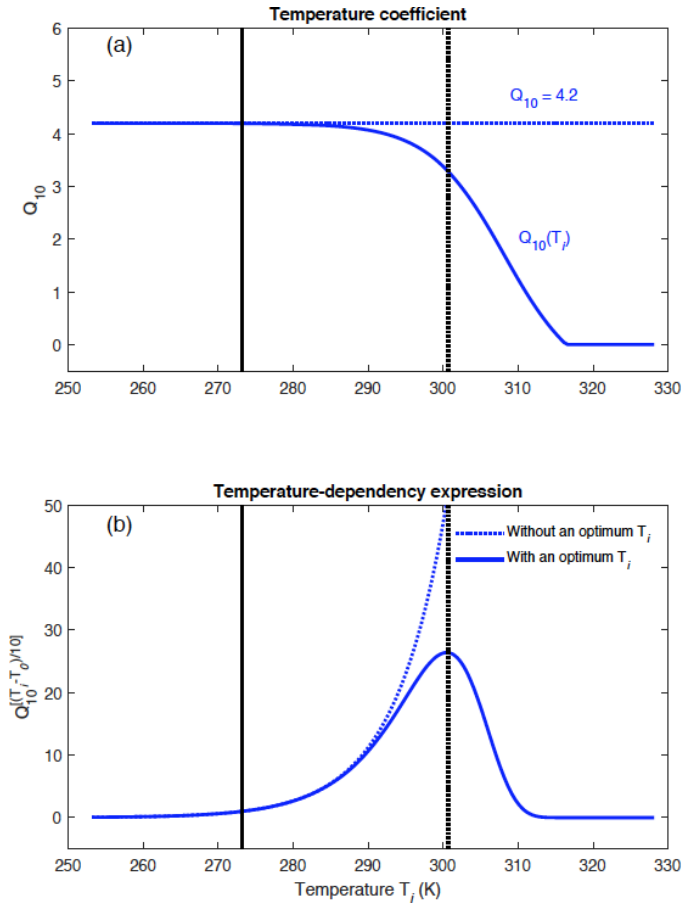
Figure A1. (a) Differences between a constant Q 10 coefficient and a temperature-dependent Q 10 (T i ) coefficient, and (b) implications for the temperature-dependency expression for CH 4 production ( Q 10 [ (T i − T 0 )/ 10 ] ). The temperature-dependent coefficient Q 10 (T i ) = 1 . 7 + 2 . 5 [ tanh ( 0 . 1 ( 308 . 15 − T i )) ] allows one to account for uncertainties in the Q 10 coefficient and to define an optimal temperature for CH 4 production of around 300.15K (dashed vertical line). The freezing point of water is shown at 273.15K (continuous vertical line).